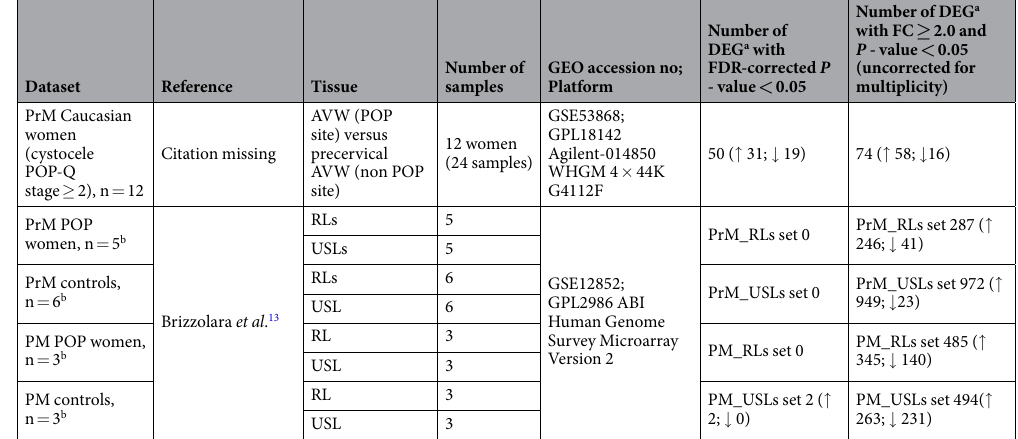
Table 2. Characteristics of the POP datasets in the Gene Expression Omnibus (GEO) database repository. a ↑ up-regulation; ↓ down-regulation; b Mixed ethnicity. Abbreviations: AVW, anterior vaginal wall; DEG, differently expressed genes; FC, fold change; FDR, false discovery rate; WHGM, whole human genome microarray; PM, postmenopausal; PrM, premenopausal; RLs, round ligaments; USLs, uterosacral ligaments.